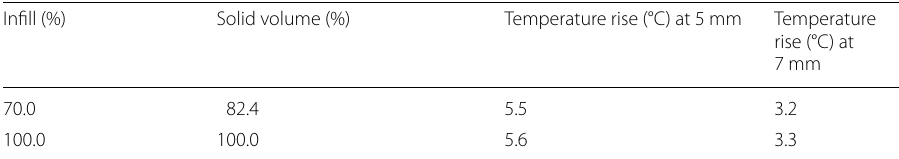
Table 3 Measured temperature rises after 20 min of heating Infill (%) Solid volume